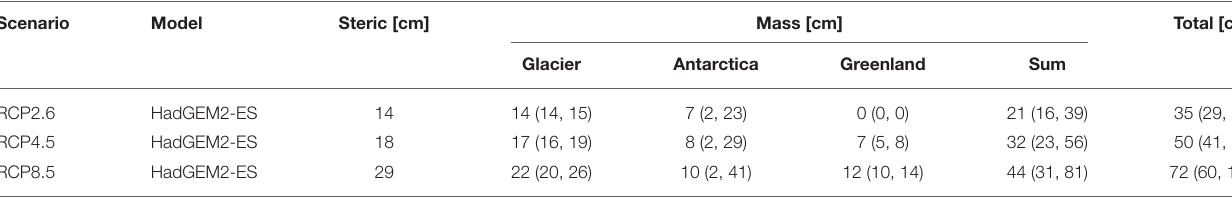
TABLE 2 | Global mean sea-level rise in 2100 with respect to 1985–2005. Scenario Model Steric [cm] Mass [cm] Total [cm] Glacier Antarctica Greenland Sum RCP2.6 HadGEM2-ES